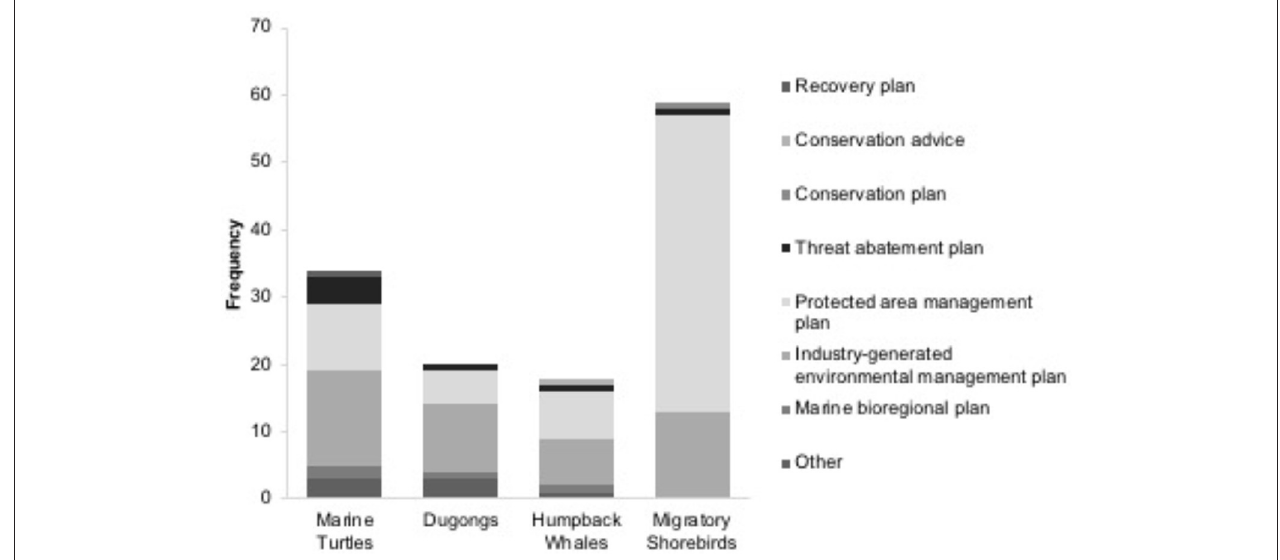
FIGURE 2 | The breakdown of relevant management plan types protecting marine turtles, dugongs, humpback whales, and 27 species of migratory shorebirds in Australia. Legend order reflects the color order (from top to bottom) of the stacked bar graph.